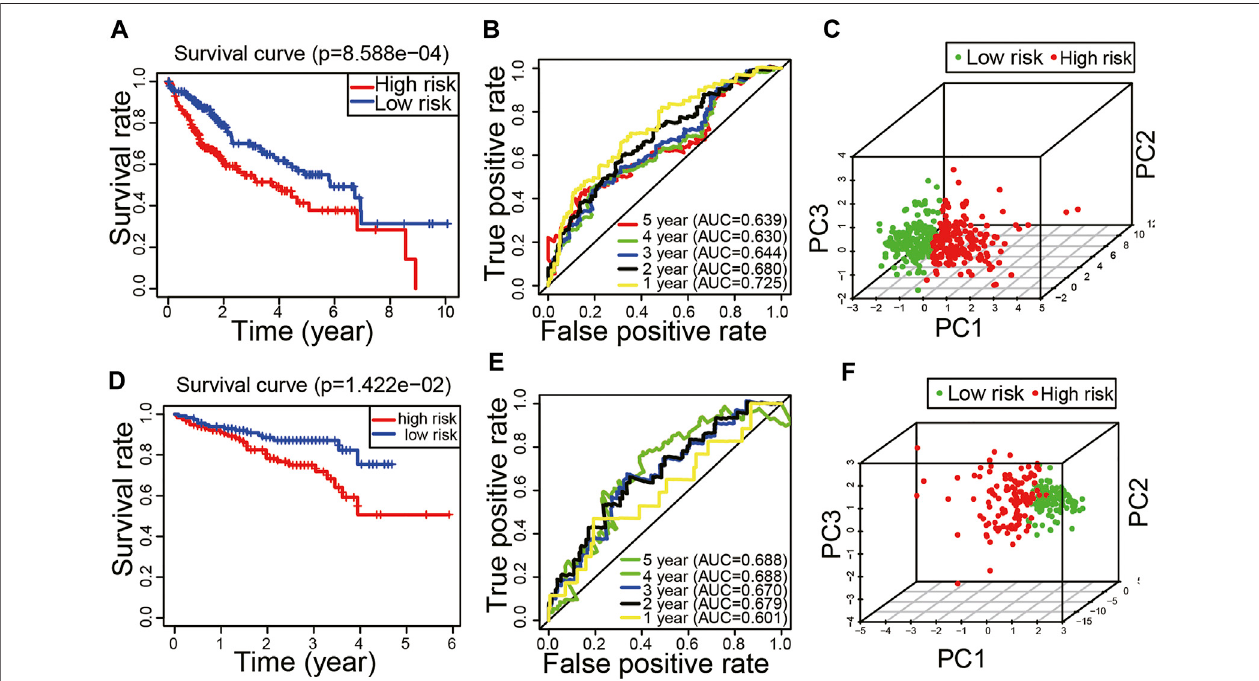
FIGURE 4 | Evaluation and validation of the peptidyl prolyl cis – trans isomerase gene signature model. (A) Kaplan – Meier curve in the training set. (B) Time- dependent receiver operating characteristic curve in the training set. (C) Principal component analysisin thetraining set. (D) Kaplan – Meier curve in thevalidationset. (E) Time-dependent receiver operating characteristic curve in the validation set. (F) Principal component analysis in the validation set.